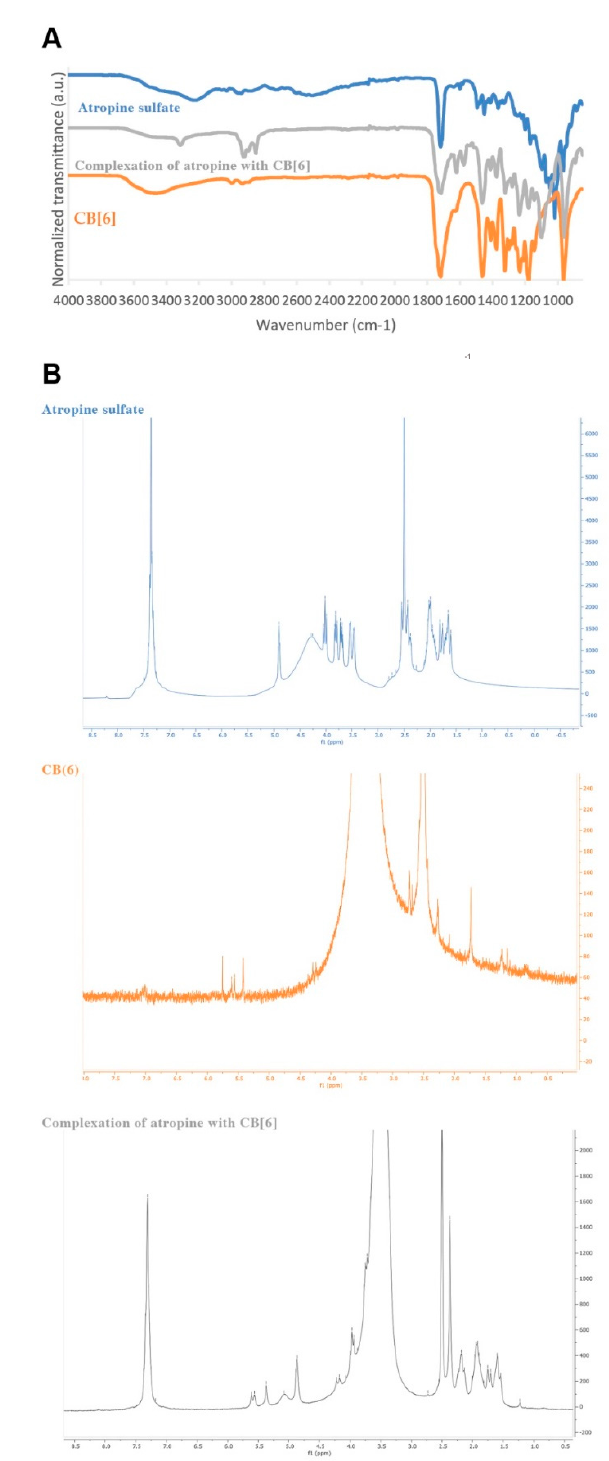
Figure 2. ( A ) IR spectra of atropine, atropine sulfate and CB[6] after kneading, and CB[6] alone (blue, grey, and orange); ( B ) 1H NMR spectrum of atropine sulfate (blue top), CB[6] (orange middle), and atropine and CB[6] after kneading (grey